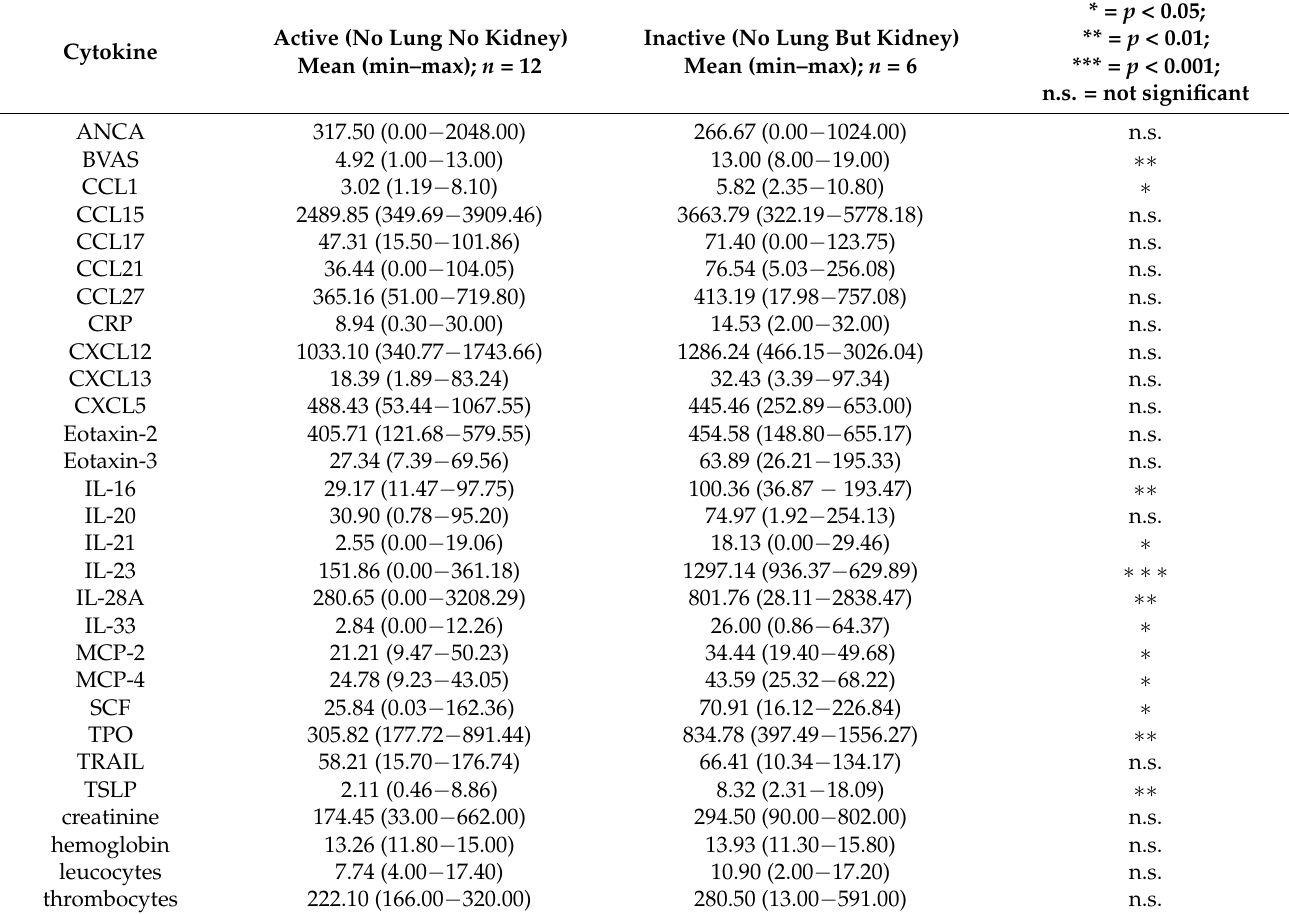
Table 6. Cytokines, laboratory parameter, PR3-ANCA titer, and BVAS at active AAV with lung involvement differentiated into patients with and without kidney